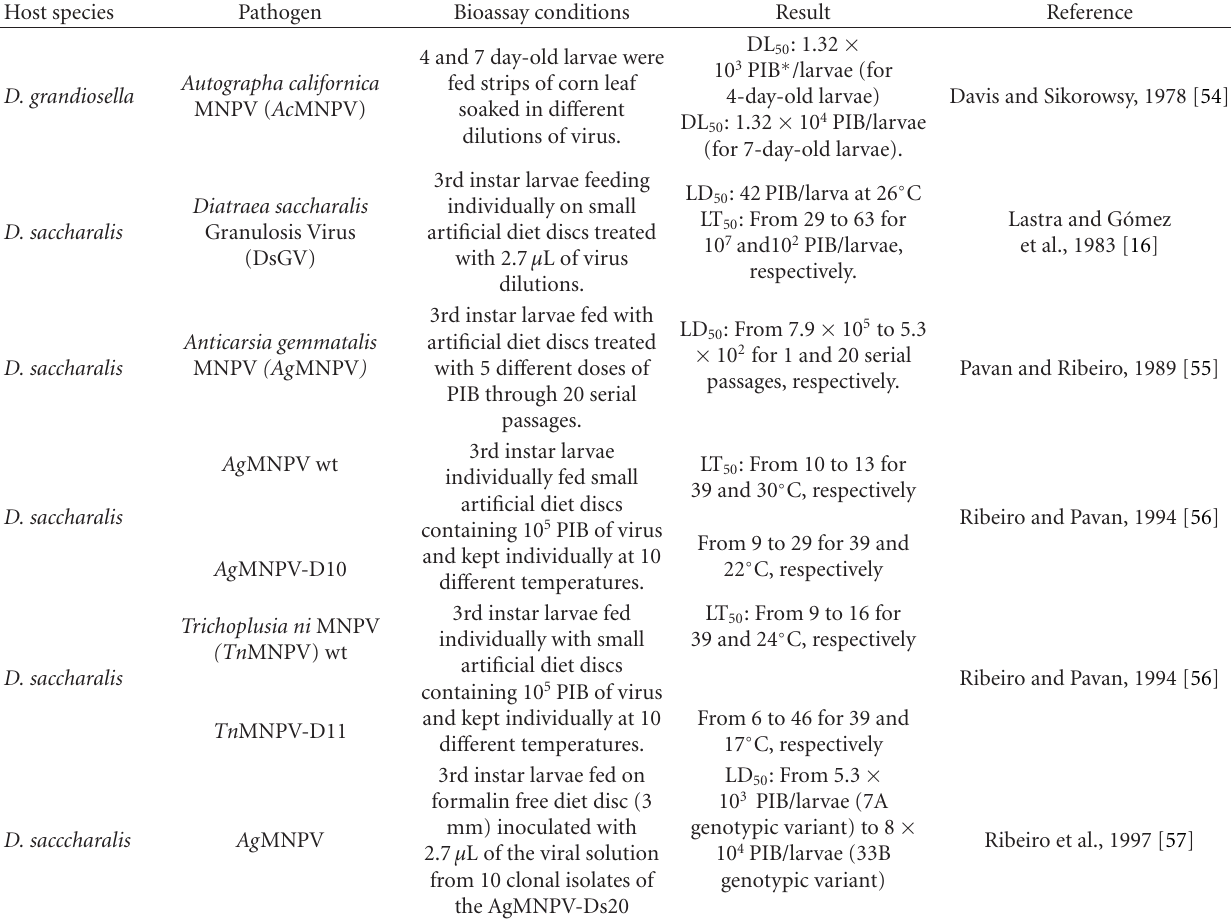
Table 6: Entomopathogenic-virus bioassays on Diatraea